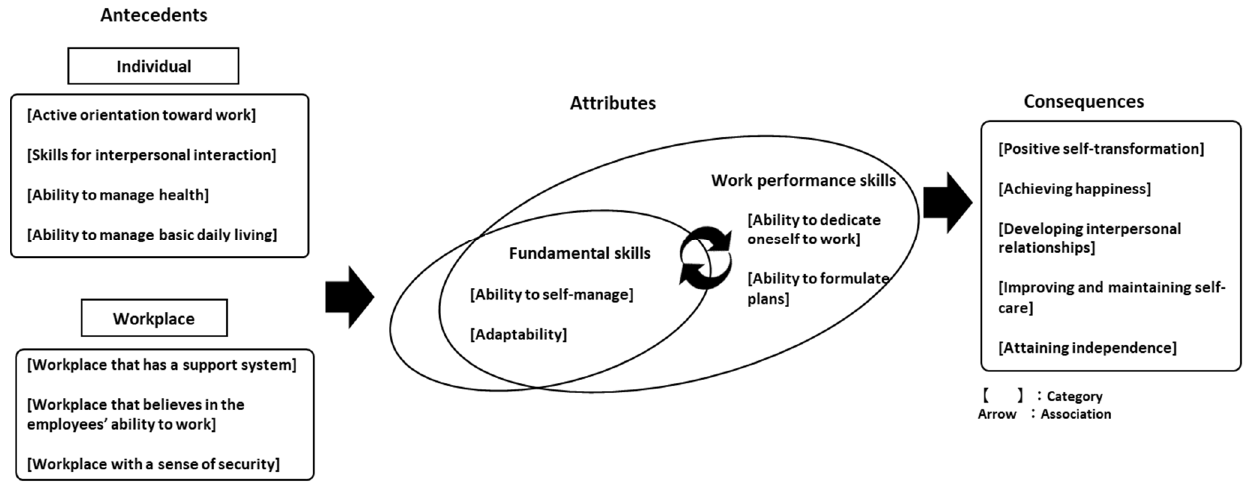
Figure 2. Conceptual diagram of the work ability of people with mental illnesses.